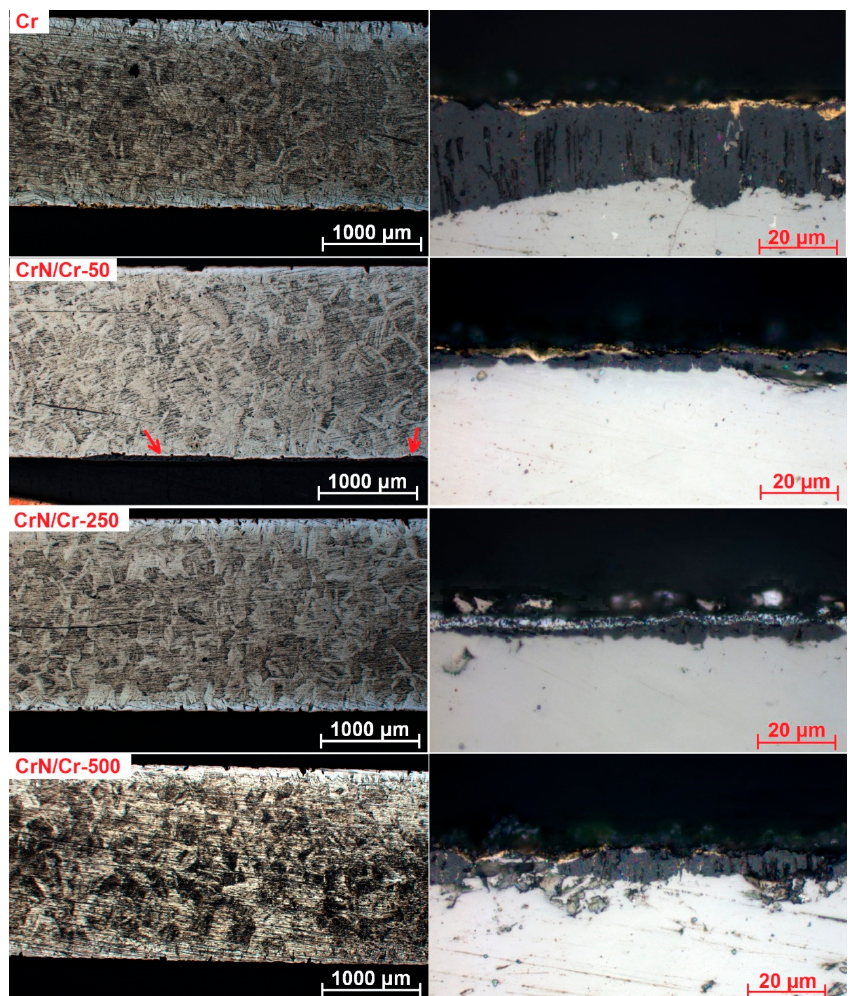
Figure 4. The optical images of the samples after 40 min oxidation. Coatings 2021 , 11 , 227 The optical images of cross-section microstructures after 40 min oxidation, outer view of the samples and their weight gains indicate less oxidation of the CrN/Cr-250 sample. Thus, the comparative study on the Cr and CrN/Cr-250 samples is further presented. Their cross-section microstructures after 20 min oxidation are shown in Figure 5.